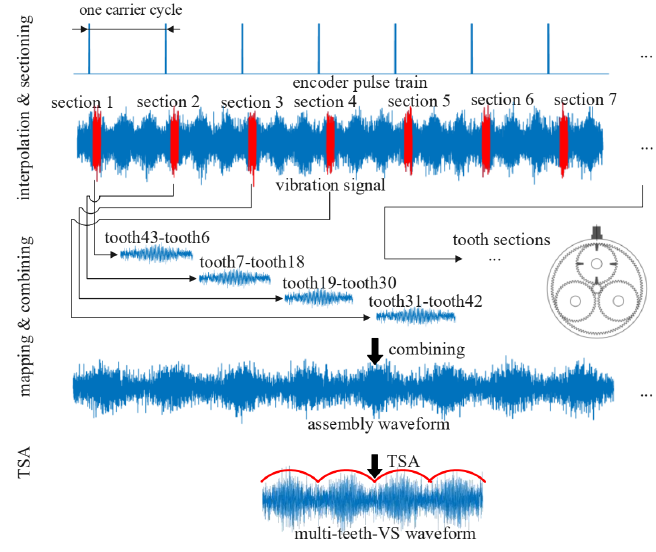
Figure 1. Schematic diagram of multi-teeth